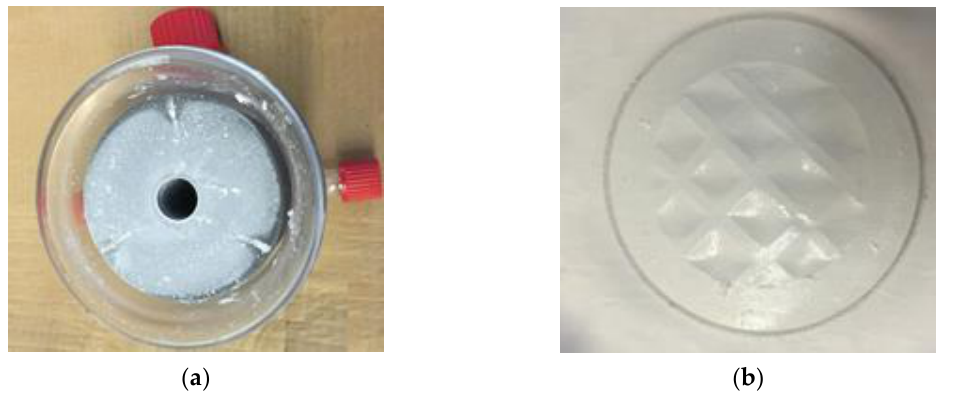
Figure 6. After the experiment with synthetic RO brine: ( a ) Membrane module; ( b ) Membrane surface. Salt crystals deposits are visible, which can easily be removed by washing with water.